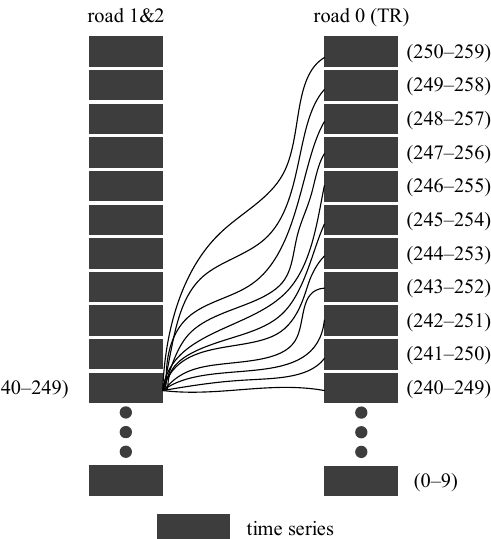
Figure 12. Schematic diagram of the time series between roads participating in the STC calculation and target roads.